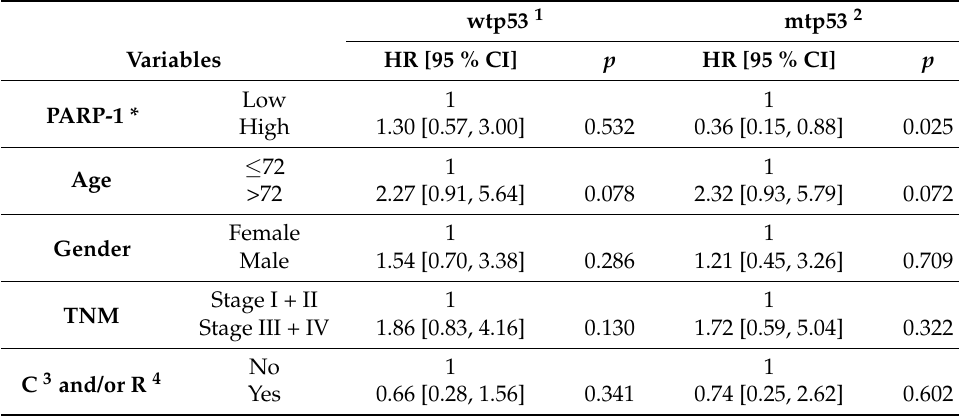
Figure 2. Kaplan–Meier curves depicting OS and DFS according to expression patterns of PARP-1 in ( a , b ) patients with p53 wild-type tumours and ( c , d ) patients with p53 mutated tumours. p values were calculated with the log-rank test. Table 2. Cox regression of prognostic factors for CRC.